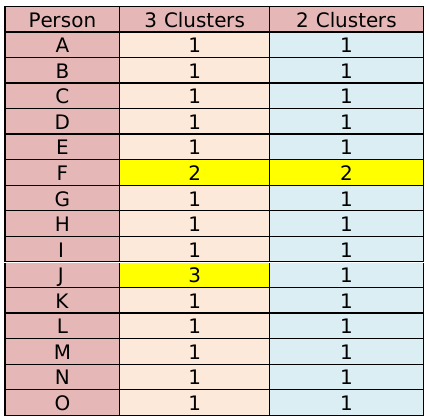
Table 1. “Cluster Analysis for Main Criteria – Attitude toward Using”.